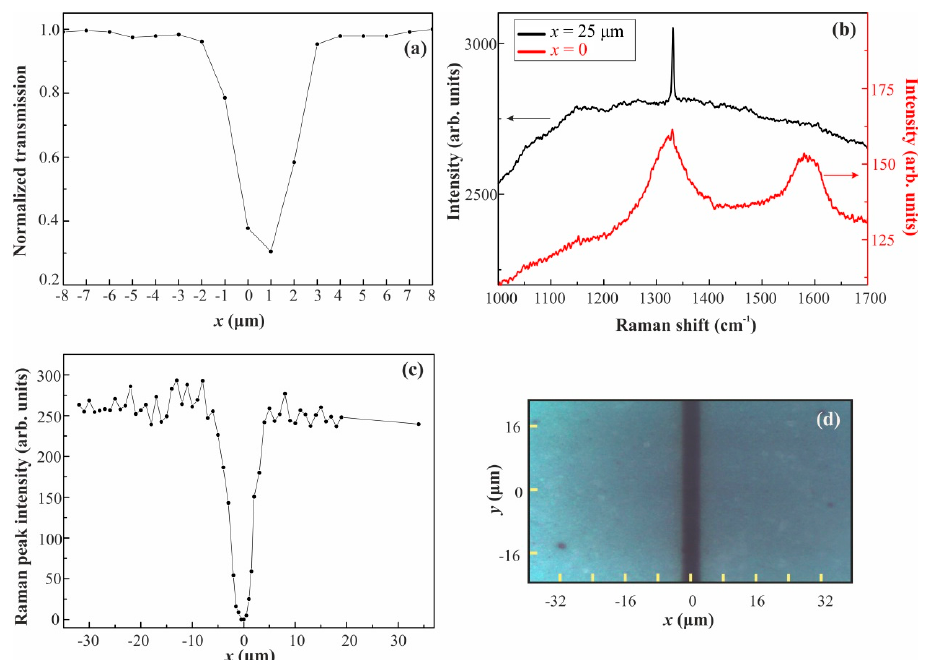
Figure 7. ( a ) Dependence of differential optical transmittance of the HP-HT nanodiamond film on x coordinate; ( b ) The Raman spectra of the HP-HT nanodiamond film points located on the x -axis perpendicular to the laser- blackened line on the film parallel to the y -axis, with x = 25 (black) and 0 (red) μ m; ( c ) the dependence of Raman peak intensity of the HP-HT nanodiamond on x coordinate; and, ( d ) an optical image of a blackened line perpendicular to the x axis.